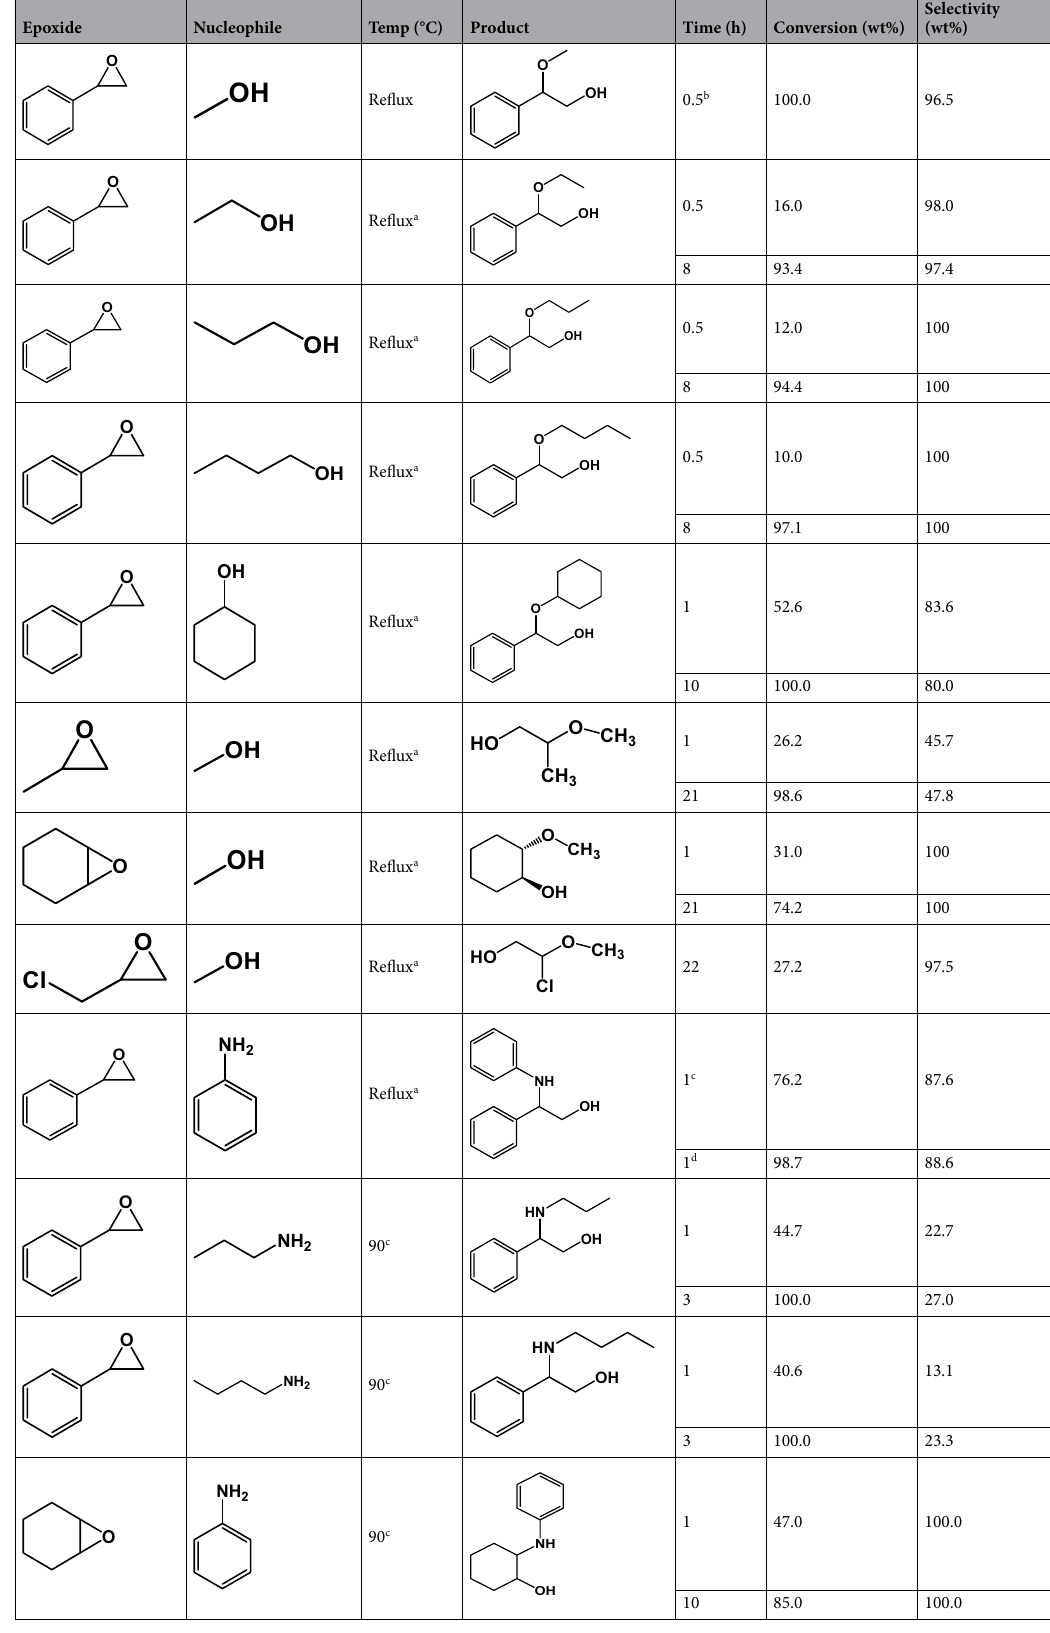
Table 4. Ring opening reaction of epoxides with various nucleophiles catalyzed by SnO 2 -T-350. Reaction conditions: a epoxide (16.6 mmol), alcohols (500 mmol), catalyst (SnO